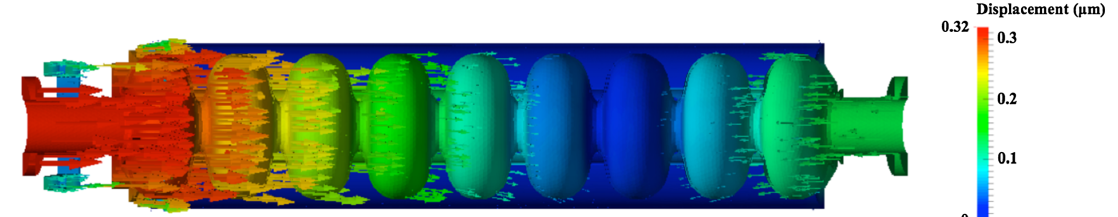
FIG. 9. Direction and magnitude of the structural displacements due to a static Lorentz